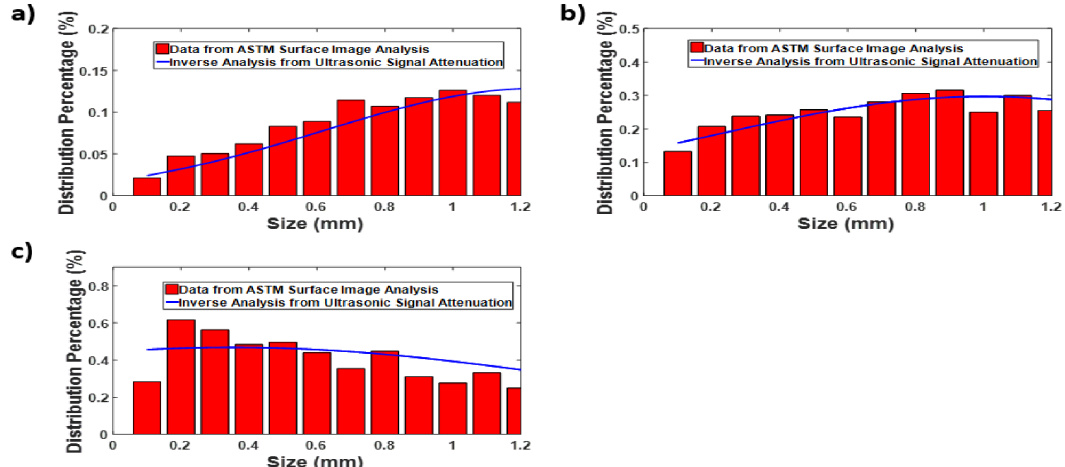
Figure 12. Comparison of the air void size distribution in the small size range. ( a ) The comparison of the experimental result and the theoretical result on the small ‐ size air voids range for Sample Type 1; ( b ) The comparison of the experimental result and the theoretical result on the small ‐ size air voids range for Sample Type 2; ( c ) The comparison of the experimental result and the theoretical result on the small ‐ size air voids range for Sample Type 3. Table 3. Inverse analysis of parameters for combined distributions.